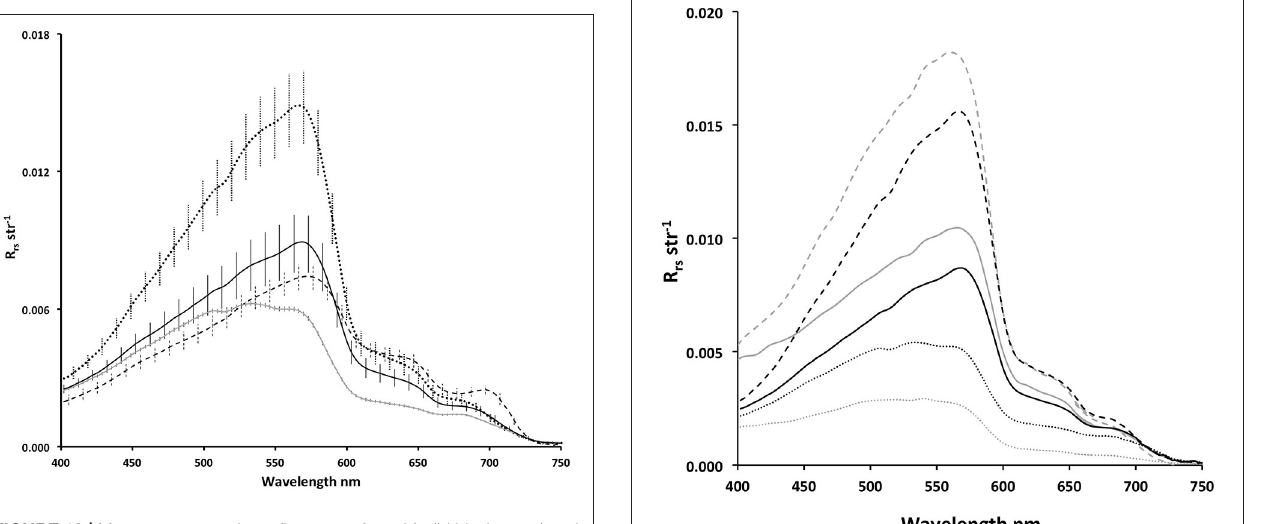
FIGURE 10 | Mean remote sensing reflectance of coral (solid black curve) and uncolonized sediment (dotted black curve) on the coconut patch reef where D < 5m, turf algae within the boat basin on Coconut Island, D < 2m (dashed black curve), and over deep water, D > 14m (solid gray curve), adjacent to the patch reef. Data representing shallow water were parsed on bottom type gleaned from manual interpretation of in-water imagery (GP1 camera). Vertical bars indicated ± 1 standard deviation relative to the mean.